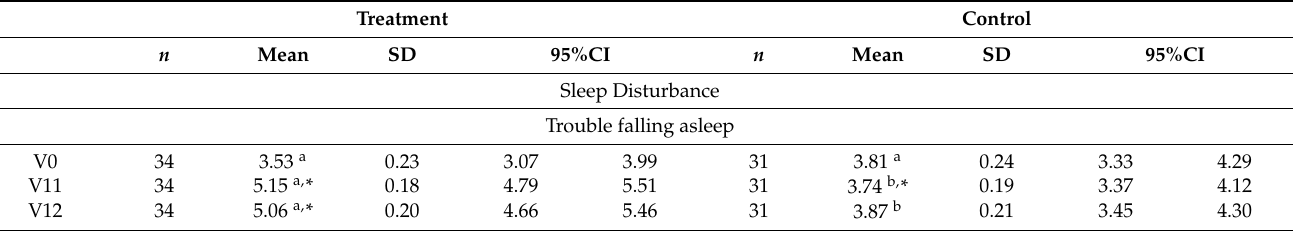
Table 6. MOS–sleep scale questionaries